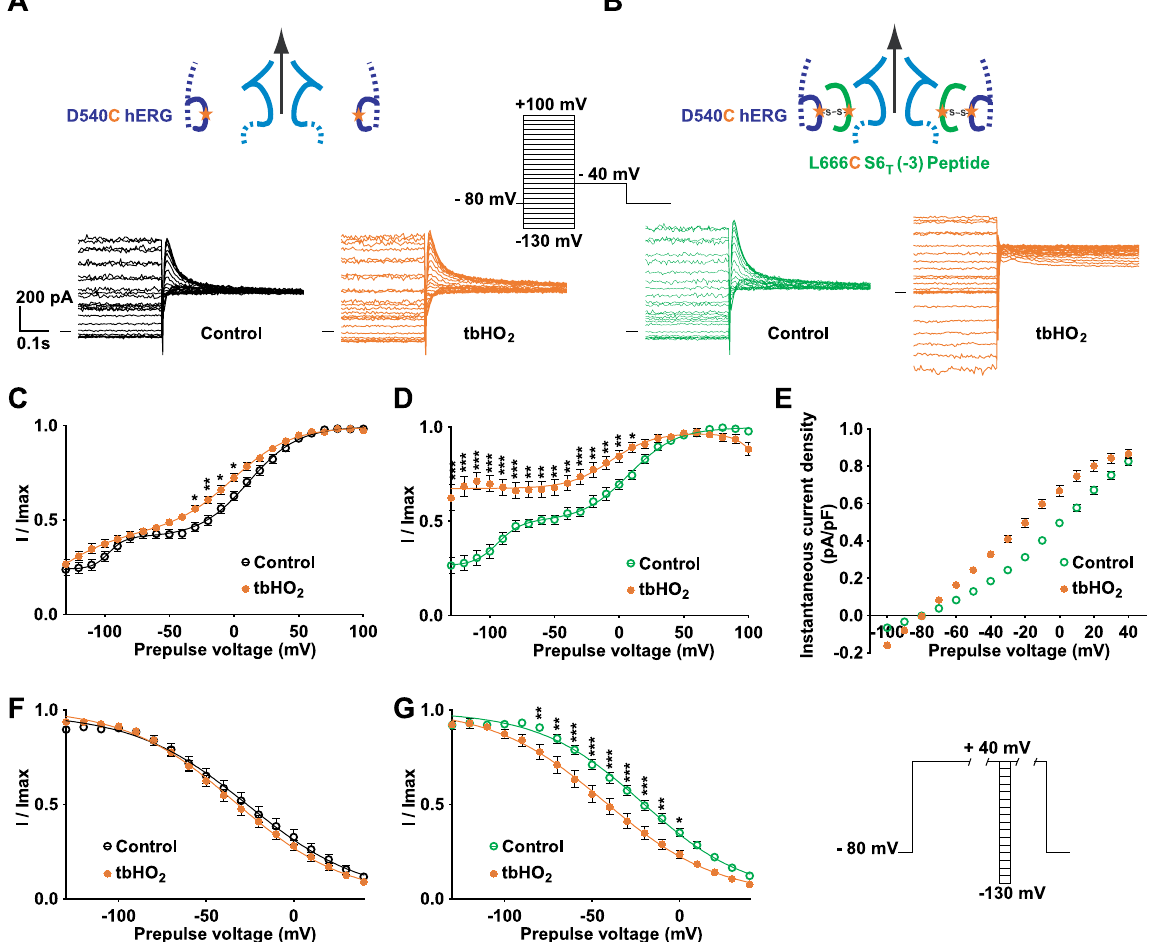
Figure 8. A cysteine disulfide bond reinforces the effect of the activating S6 T peptide, rendering the channel almost voltage independent. ( A , B ) Representative superimposed recordings of the single mutant D540C hERG current ( A , 1 µ g D540C hERG plus 3 µ g GFP plasmids) and D540C hERG current in the presence of L666C S6 T ( − 3) peptide ( B , 1 µ g D540C hERG plus 3 µ g peptide plasmids) after 2 h incubation in Tyrode without (control) and with 0.2 mM tbHO 2 (tbHO 2 ), using the voltage protocol shown in inset. ( C , D ) Activation curve, with a double Boltzmann, obtained from the tail currents in the same conditions as A, in the absence ( C ) or presence of the L666C S6 T ( − 3) peptide ( D ). ( E ) Maximum current density measured during the prepulse, using the protocol and conditions as in ( A ). ( F , G ) D540C hERG inactivation curve obtained using the protocol shown in right inset (same as in Fig. 2), in the absence ( F ) or presence of the L666C S6 T ( − 3) peptide ( G ). * p < 0.05, ** p < 0.01, *** p < 0.001, two way ANOVA with Bonferroni